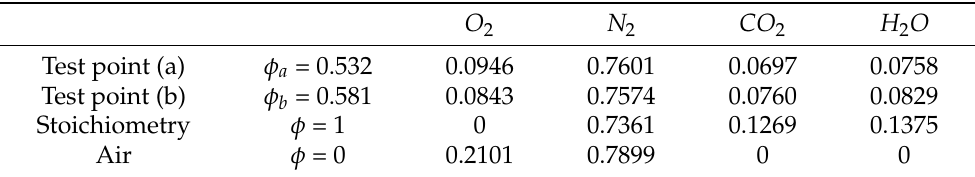
Table 5. Molar fractions of exhaust gases; unit: